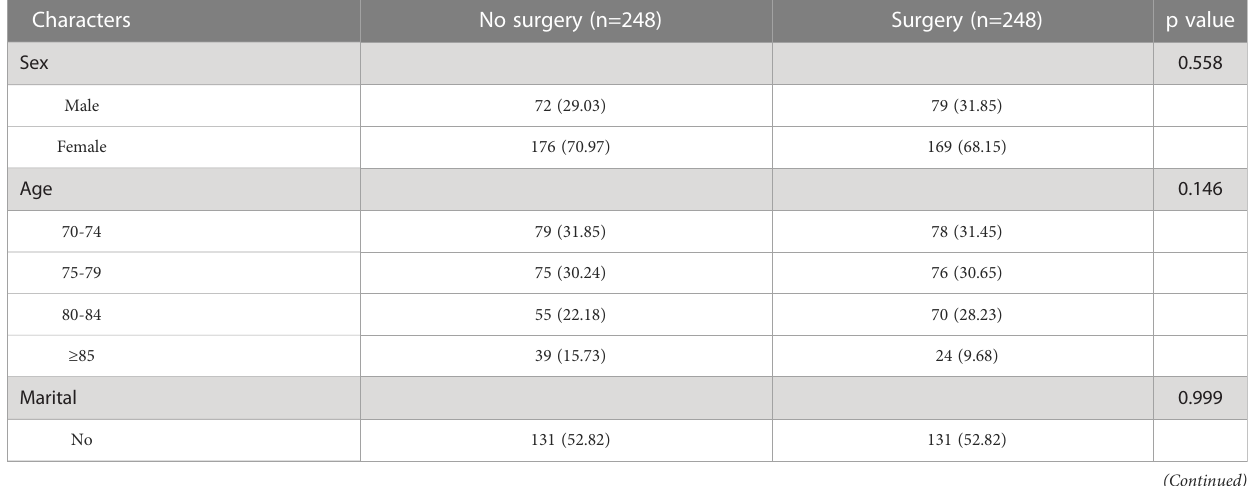
TABLE 2 Clinical characteristics of elderly patients with GBC after propensity score